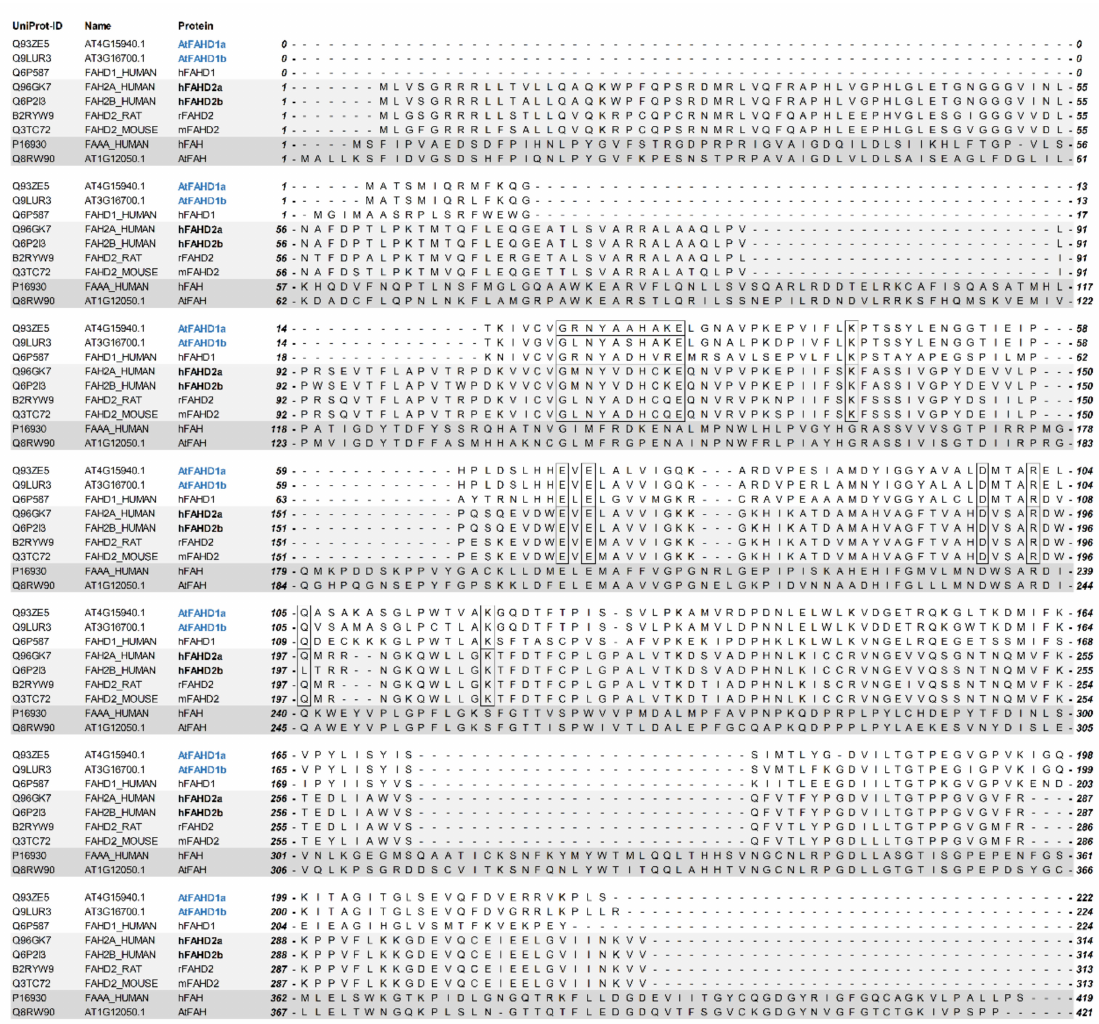
Figure 1. Multiple sequence alignment of the three Arabidopsis thaliana (At) fumarylacetoacetate hydrolase domain (FAHD)- containing proteins with orthologues. White and light grey shadings indicate the highest homology of AT4G15940.1 and AT3G16700.1 with human FAHD-containing protein 1 (hFAHD1), and they all differ from FAHD2 proteins in the N-terminus. AT1G12050.1 is orthologue to human fumarylacetoacetate hydrolase (hFAH) and was already identified as AtFAH [18]. Black borders refer to amino acids critical for the catalytic reaction of hFAHD1, which were fully conserved in AT4G15940.1 and AT3G16700.1. Their BLASTp alignment with hFAHD1 revealed sequence identities of 53 and 49%, respectively. Therefore, similar to the nomenclature assigned to hFAHD2a and hFAHD2b in human, AT4G15940.1 and AT3G16700.1 were renamed as AtFAHD1a and AtFAHD1b,